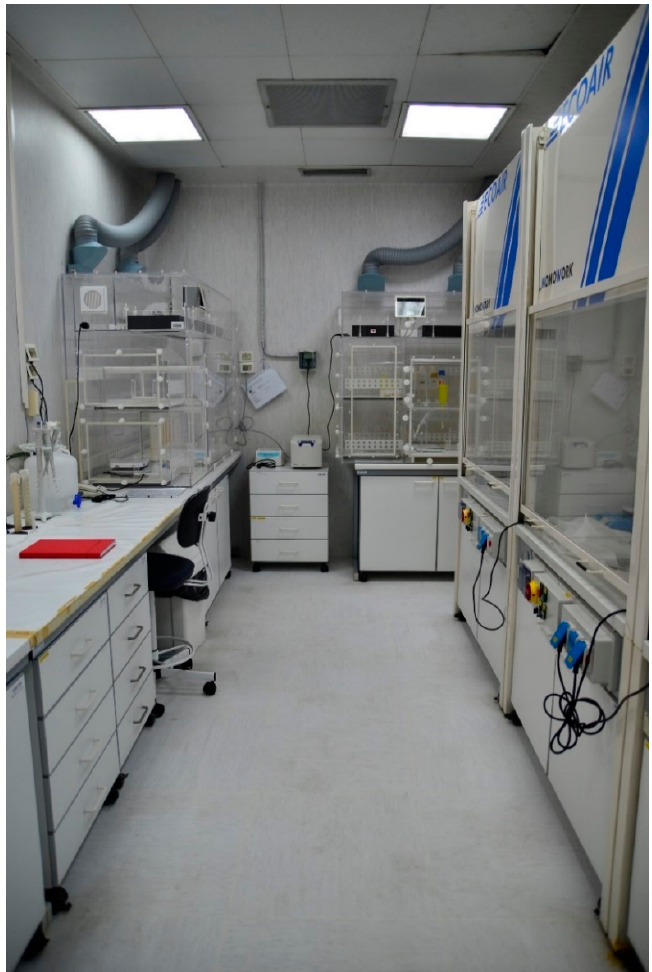
Figure 1. The Clean chemistry laboratory of the Istituto Nazionale di Geofisica e Vulcanologia (INGV), Sezione Osservatorio Vesuviano (OV) .